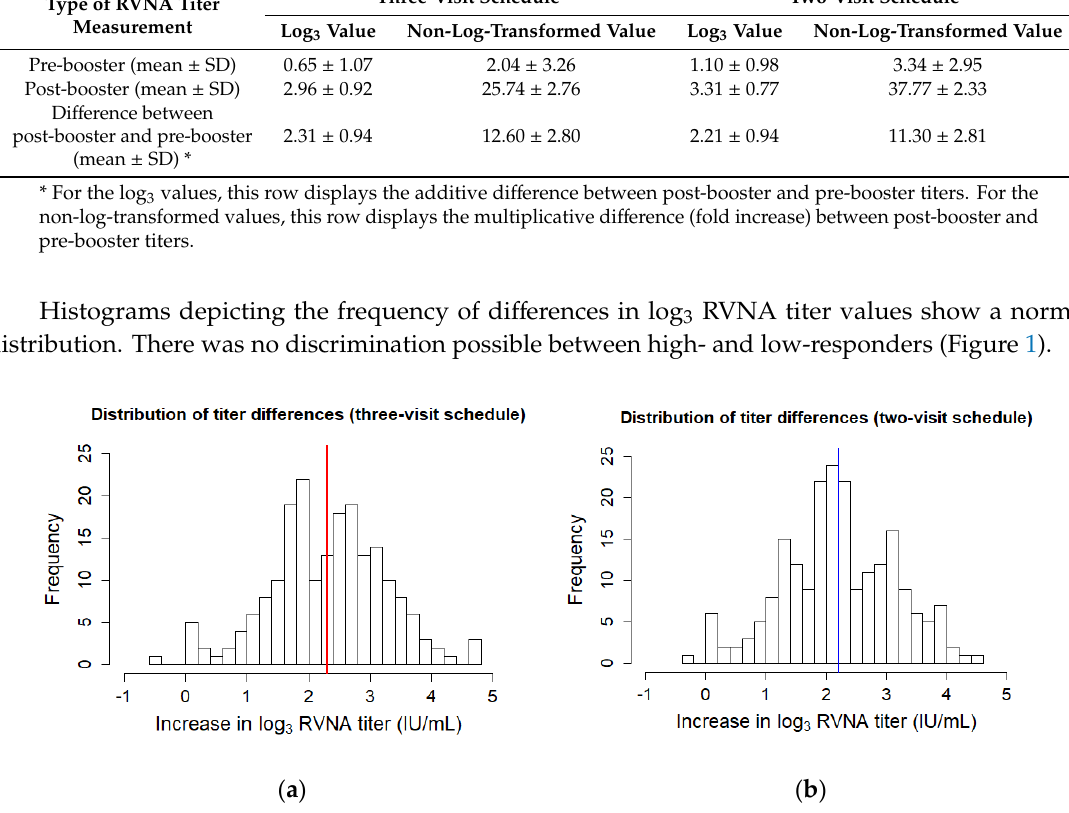
Figure 1. Histograms depicting the frequencies of the pre- and post-booster differences in log 3 titer for the ( a ) three-visit schedule and ( b ) two-visit schedule. The mean difference is plotted as a thick